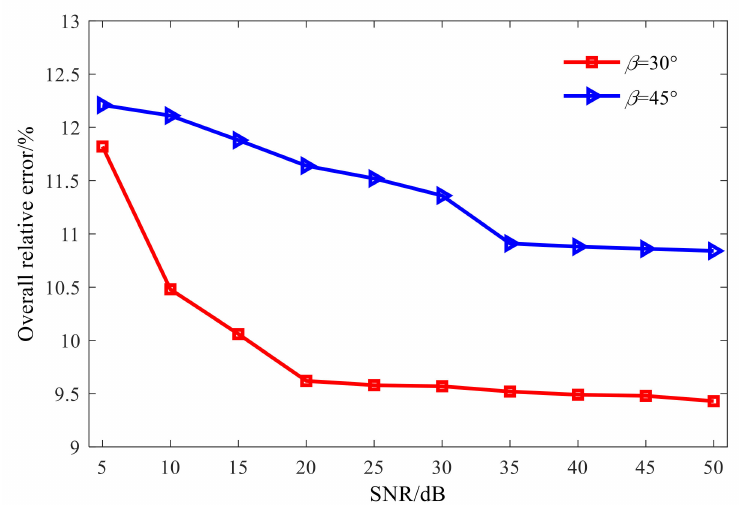
Figure 20. Overall relative errors of the proposed